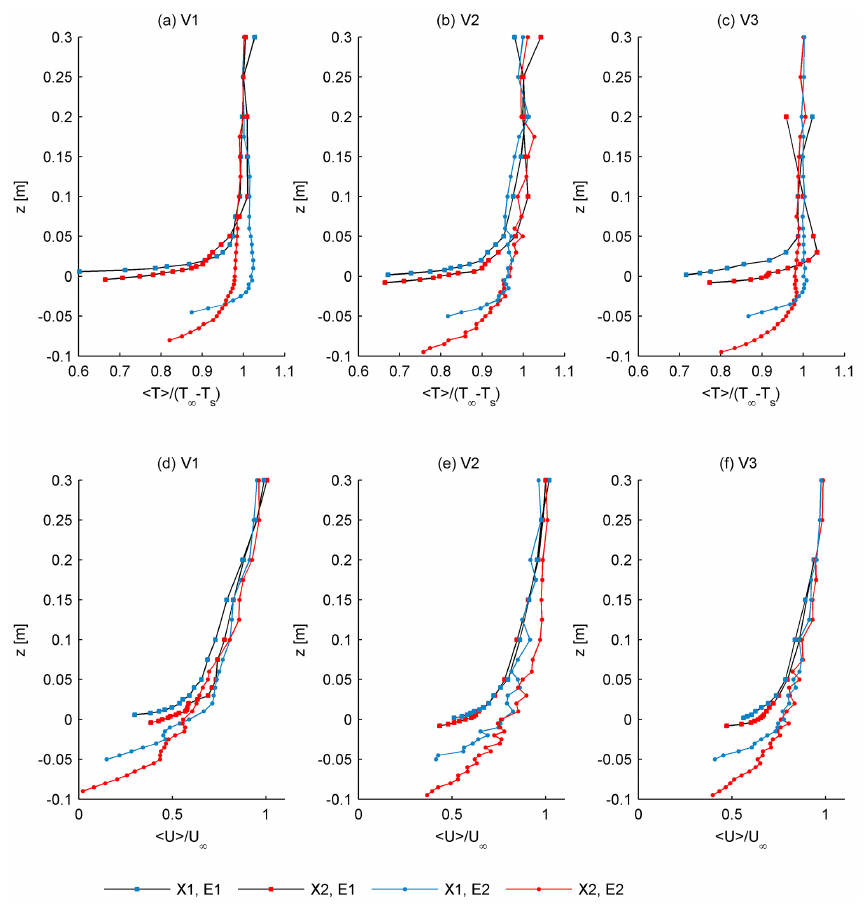
Figure 2. Vertical profiles of the mean air temperature (top) and wind velocity (bottom) normalized by the free-stream temperature/wind